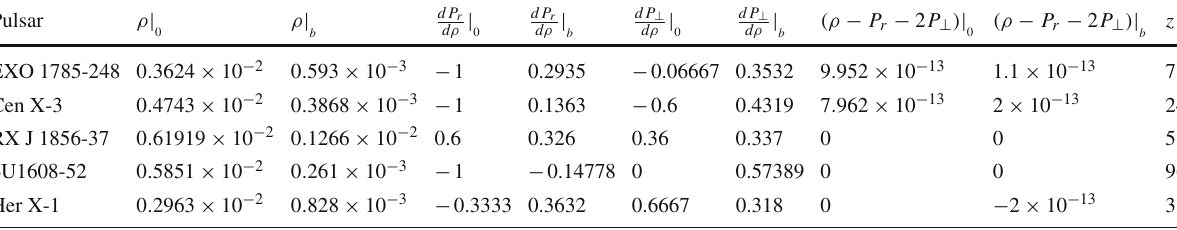
Table 2 Values of physical quantities at c 1 = 0